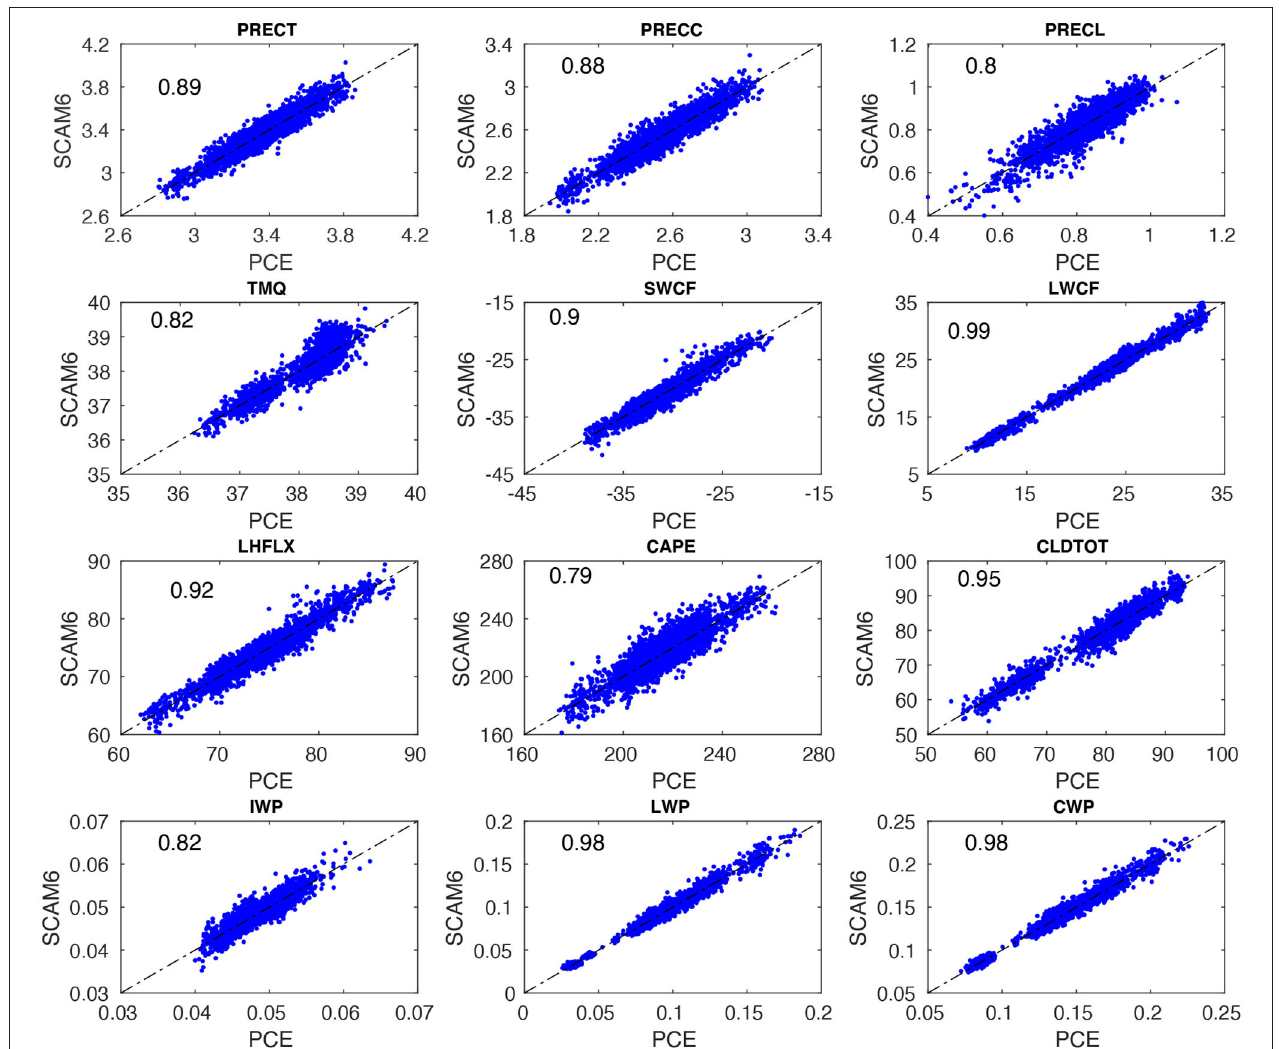
FIGURE 3 | Scatter plots of PC-fitted outputs vs. SCAM6 simulations for various climate variables. Row 1 corresponds to total precipitation (PRECT), convective precipitation (PRECC), and large-scale precipitation (PRECL). Row 2 corresponds to total precipitable water (TMQ), shortwave cloud radiative effect (SWCF), and longwave cloud radiative effect (LWCF). Row 3 corresponds to latent heat flux (LHFLX), convective available potential energy (CAPE), and total cloud cover (CLDTOT). Row 4 is similar to the previous rows but for ice water path (IWP), liquid water path (LWP), and cloud water path (CWP). The fraction (0–1) of the total variance of SCAM6 simulations explained by the PC-based surrogate model for various climatic variables is indicated by numbers in the upper left of each panel.